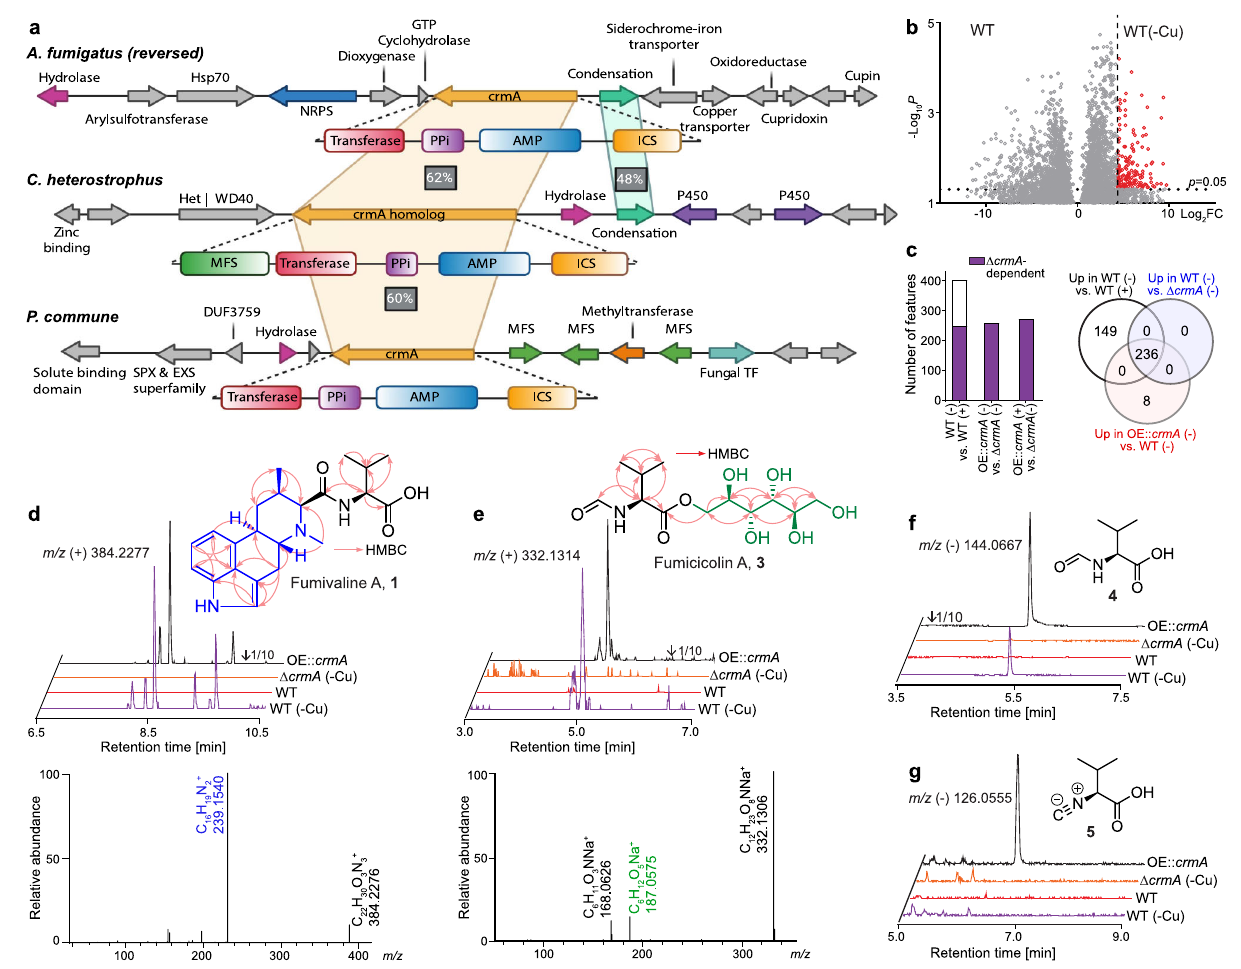
Fig. 1 | The crm BGC and associated metabolites from A. fumigatus . a Comparison of crm BGCs in A. fumigatus , P. commune , and C. heterostrophus . Homologous genes are marked with colors based on their corresponding func- tions. b Volcanoplotofdifferentialmetabolitesinwildtypeupregulatedbycopper starvation (red dots represent metabolites 20-fold upregulated at p <0.05 as cal- culated by unpaired two-sided t -test, unadjusted for the number of comparisons, based on 6 independent replicates). c Total number of crmA -dependent metabo- lites in wildtype upregulated by copper starvation or crmA overexpression com- pared to the crmA deletion mutant and Venn diagram showing overlap of